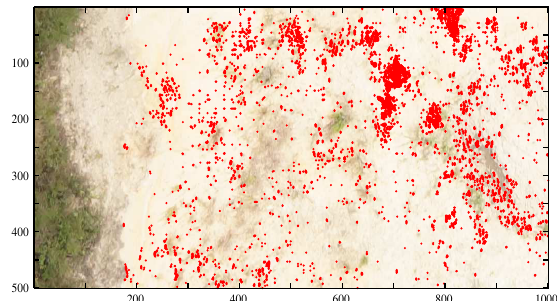
Figure 6: Subset of saturated image, the red dots indicate pixels with fully saturated intensity. On the left bright sand is visible as well, however this is part of the sand wall and its normal is not directed to the camera.